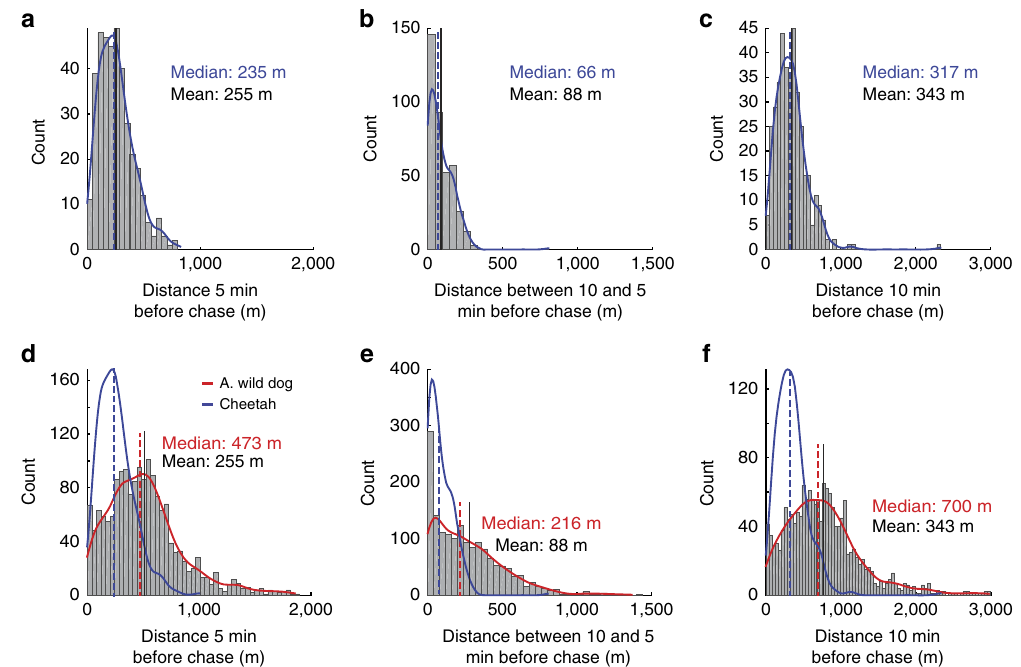
Figure 5 | Comparison of African wild dog and cheetah hunt parameters. Histogram and kernel density estimate for cheetah ( a – c ; number of cheetahs N ¼ 5; number of hunts n ¼ 381) and African wild dog ( d – f ; number of dogs N ¼ 6; number of hunts n ¼ 1,119; including cheetah kernel density estimate normalized to African wild dog count (blue)). Distance covered 5min before the start of chase ( a , d ) between 5 and 10min before chase ( b , e ) and 10min before chase ( c , f ).